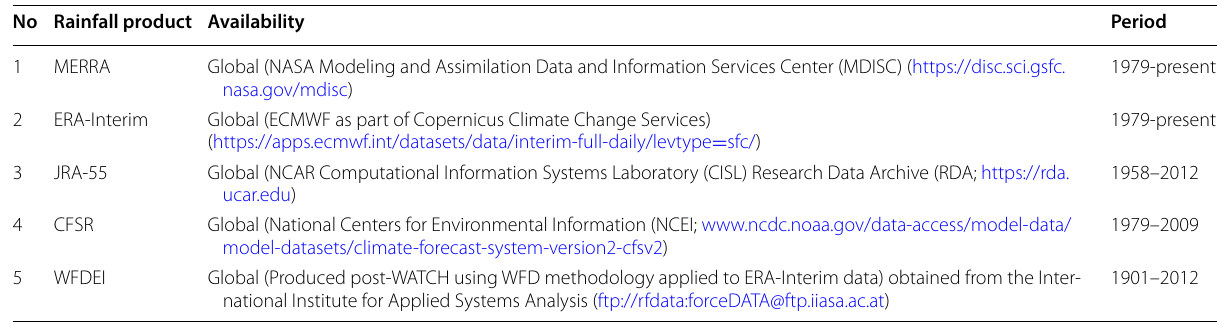
Table 1 Description of various reanalysis and global meteorological data No Rainfall product Availability Period